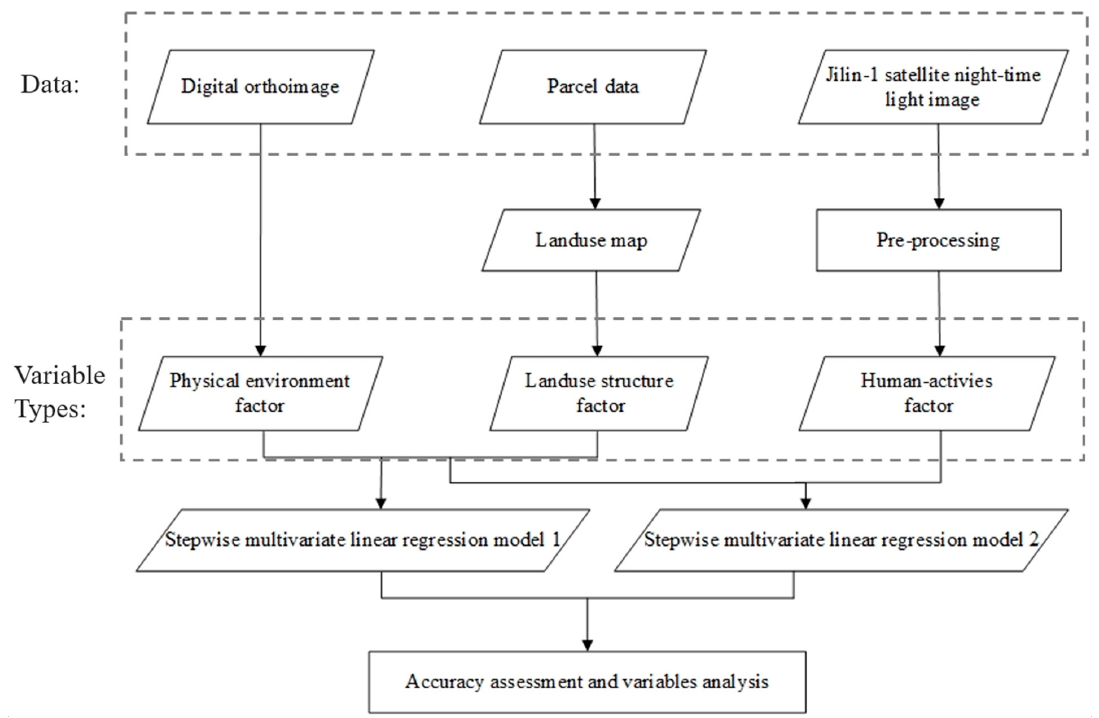
Figure 3. Methodology flowchart.